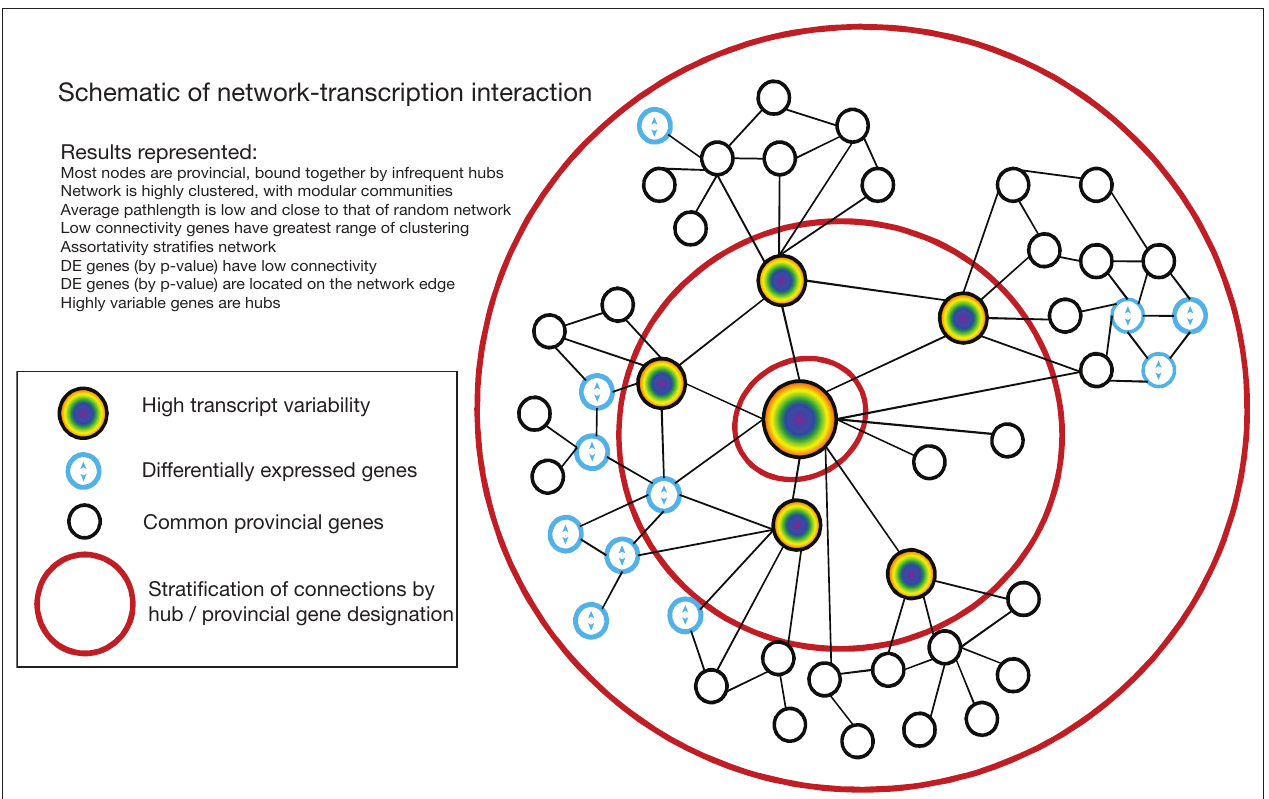
Figure 6 | Schematic of relationship between network structure and differential expression incorporating all